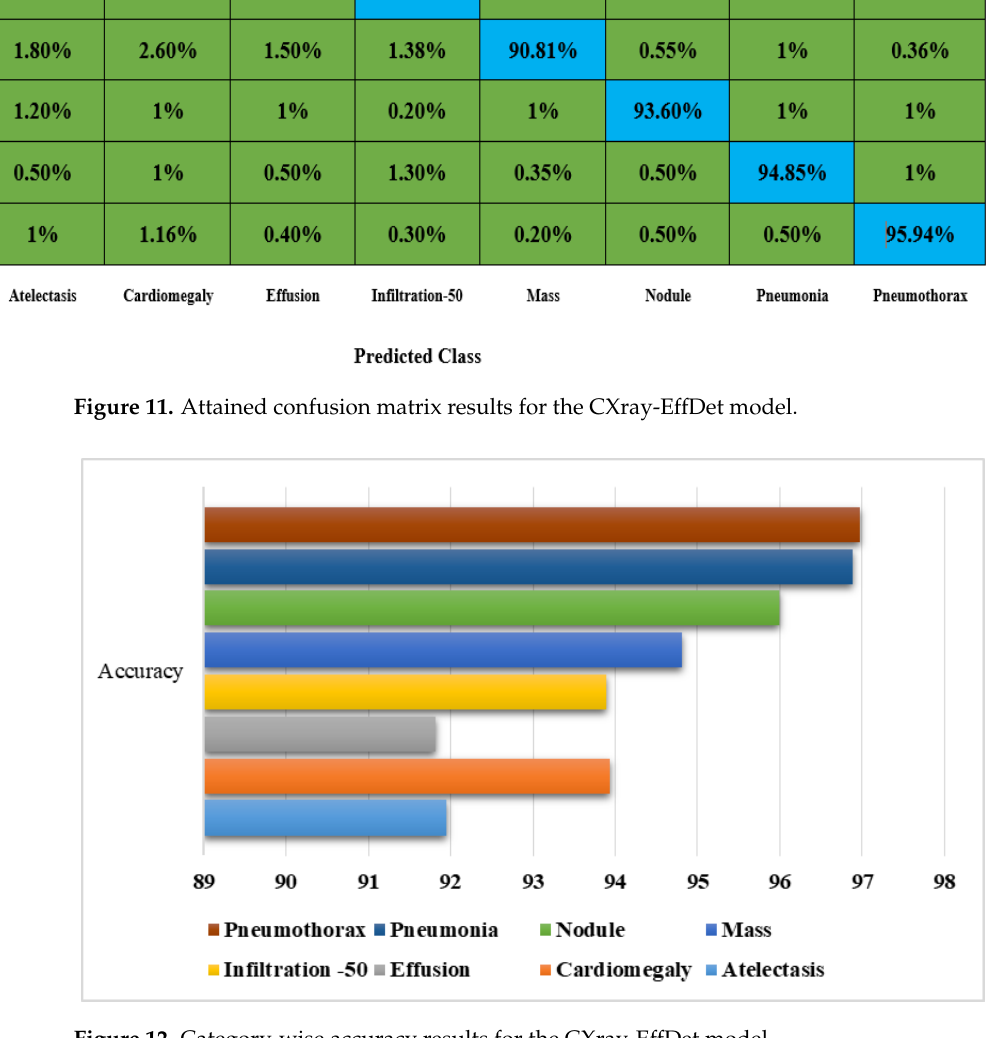
Figure 12. Category-wise accuracy results for the CXray-EffDet model .